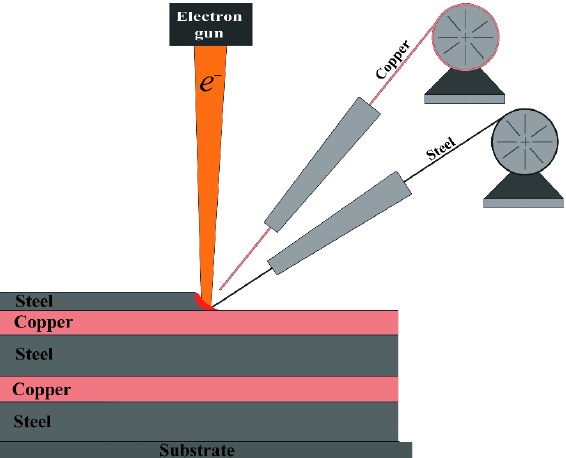
Figure 1. Scheme of a “copper–steel” material building using the electron beam additive manufacturing. Table 1. Chemical composition of copper and steel wires.